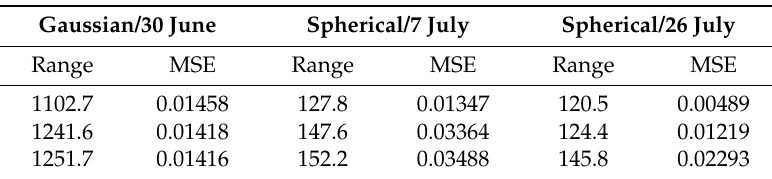
Table 2. Semivariogram sensitivity analysis to the model range (m) on 30 June, 7 July, and 26 July with indicator, MSE (m 3 · m − 3 ) 2 : the mean squared error.